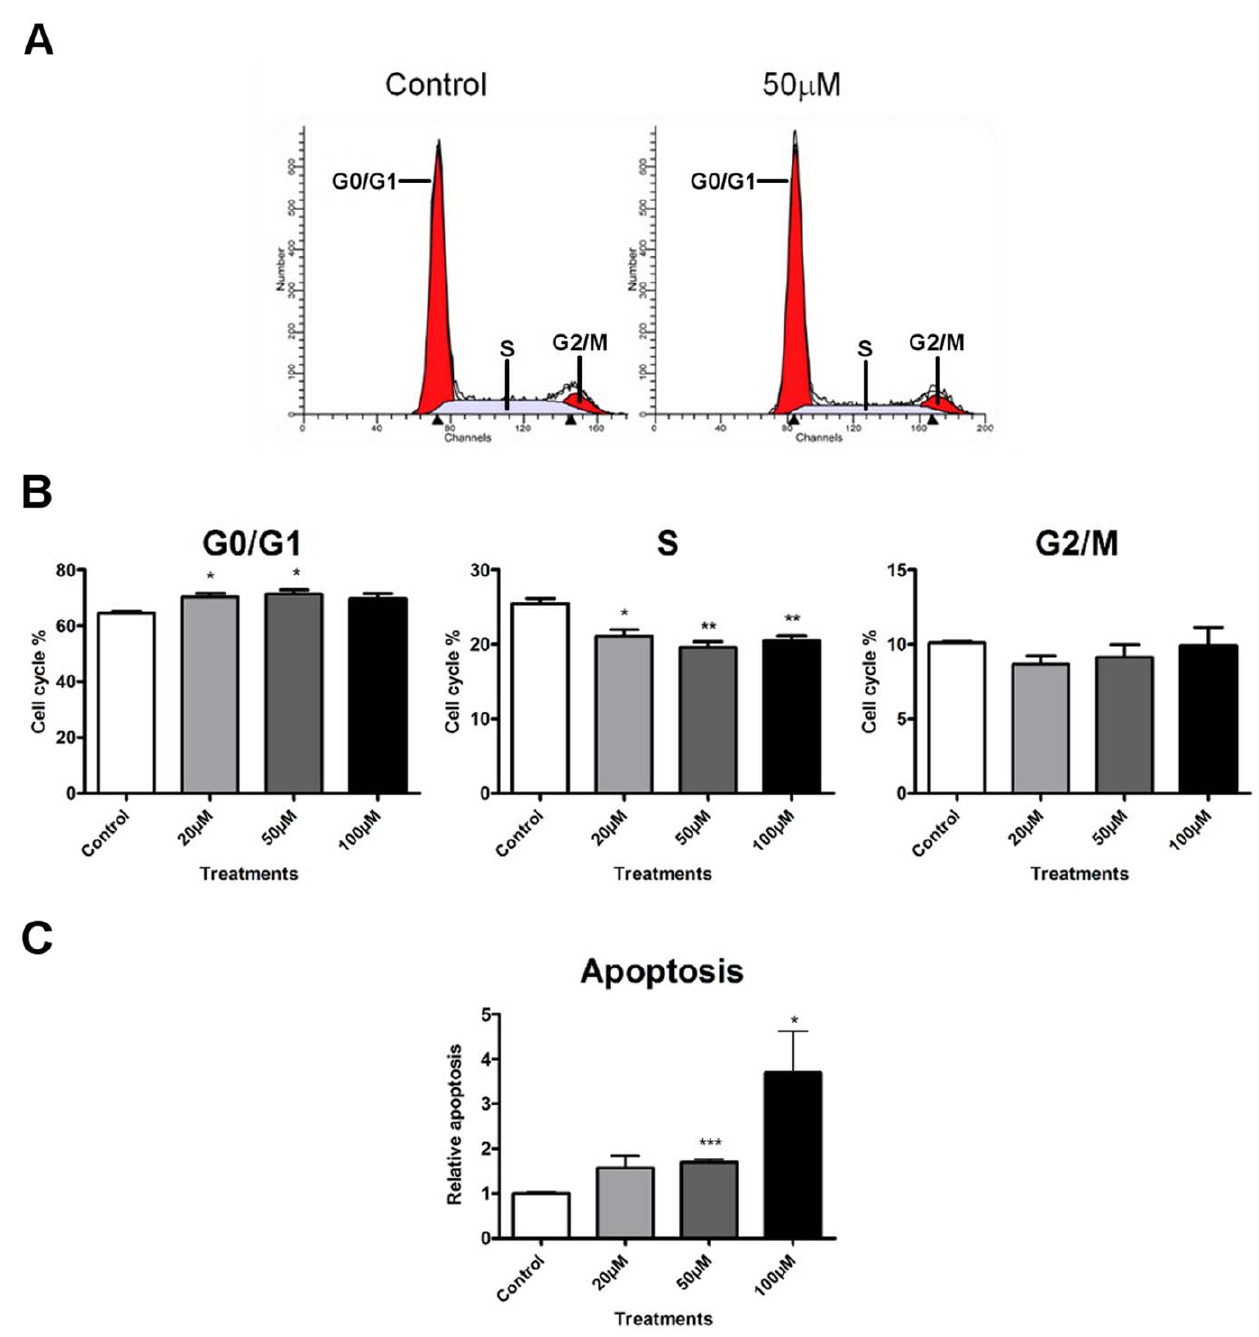
Figure 7. The treatment of HeLa cells with Max* induces cell cycle arrest and apoptosis. A) Representative cell cycle distribution determined by flow cytometry (FACS) and propidium iodide (PI) labeling with (right) and without (left) treatment (50 m M, 72 hours) with Max*. B) Histogram representation of the populations of HeLa cells in each phase as a function of treatment concentration. C) Relative level of apoptotic cells as determined by sub-G1 events. N=3, * P , 0.05, ** P , 0.01 and *** P , 0.0001. doi:10.1371/journal.pone.0032172.g007 thiogalactopyranosid). After a growth period of four hours, cells containing Ampicillin (50 m g/ml) and Chloramphenicol (34 m g/ml) and were harvested by centrifugation. Soluble protein extracts were grown at 37 u C overnight. Using a single colony, a pre-culture was then purified by cation-exchange chromatography columns (GE inoculated in 2YT medium with fresh antibiotics and grown for an Healthcare) to isolate highly pure recombinant proteins as additional 16 hours. 5 L of culture was then prepared using a 2% previously described [36]. The fractions containing the Max* or dilution from the pre-culture. The cultures were allowed to grow the Max*HA proteins were collected, desalted on HighTrap until turbidity reached 0.8 (D.O. at 595 nm) where protein desalting columns (GE Healthcare) using 0.05% H2O N TFA and expression was induced with 0.6 m M of IPTG (Isopropyl-ß-D-